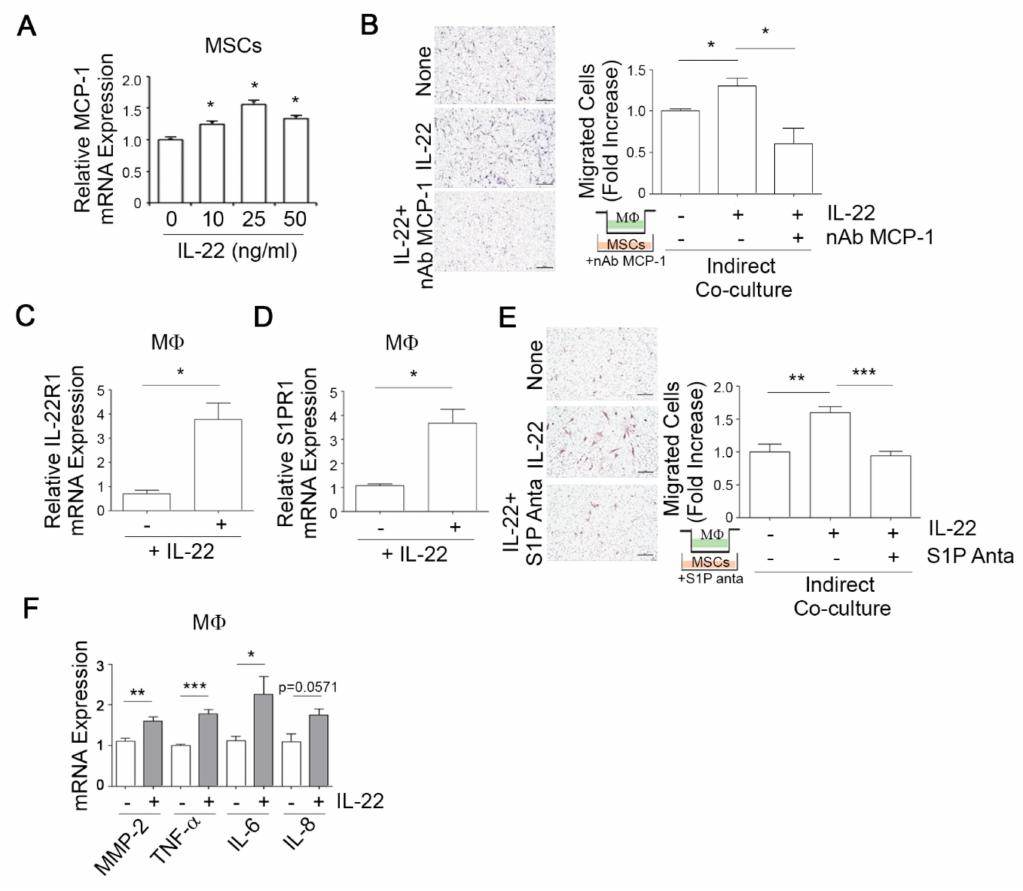
Figure 4. IL-22-induced monocyte chemoattractant protein 1 (MCP-1) in MSCs increases macrophage infiltration. ( A ) IL-22 induces the expression of MCP-1 in human bone marrow-derived MSCs. MSCs were stimulated with IL-22 for 24 h and then MCP-1 mRNA expression was analyzed by qPCR. ( B ) Macrophage infiltration is dependent on IL-22-induced MCP-1 in MSCs. MSCs were